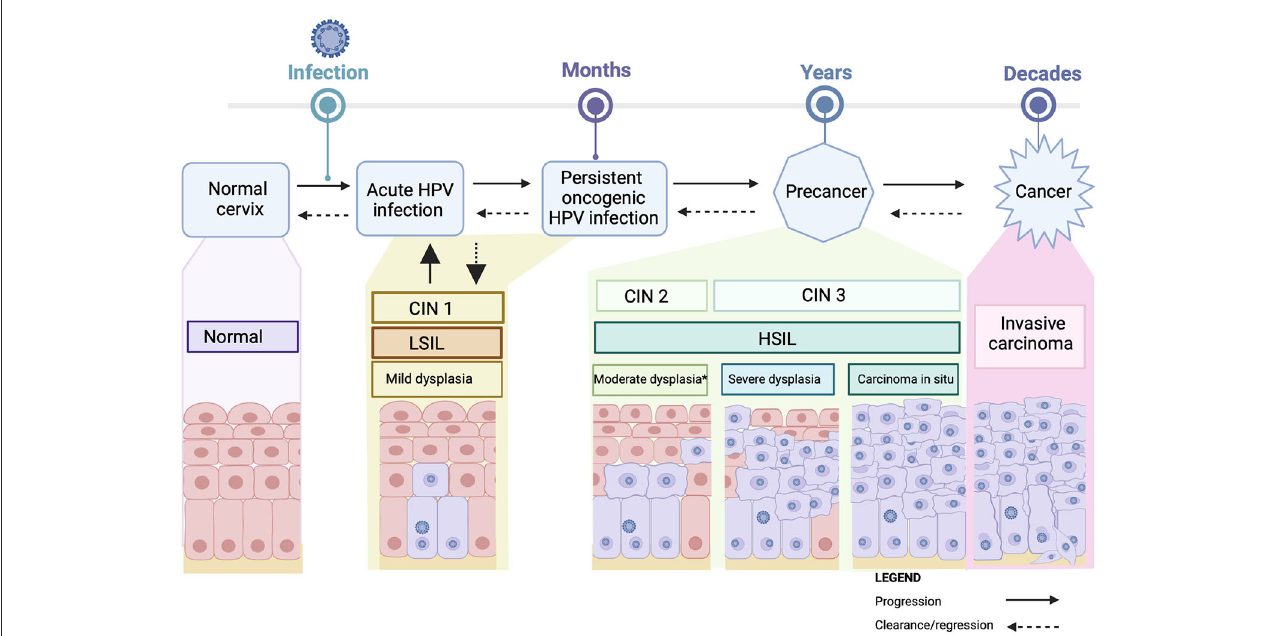
FIGURE1 Cervical carcinogenesis. Acute Infection with HPV may cause mild cervical abnormalities [CIN I (mild dysplasia/LSIL)], which usually clear spontaneously. Persistent infection with oncogenic HPV can result in cervical pre-cancerous lesions [CIN 2 (moderate dysplasia), CIN3 (severe dysplasia or carcinoma in situ /HSIL)] which can progress over time to invasive cancer. Progression is not inevitable, with regression possible at any stage. * sometimes acute infections/infections with lower risk HPV types can produce an appearance that is identified as moderate disease (CIN2). CIN2 is a heterogeneous entity likely comprising “severe CIN1 cases” and “mild CIN2” cases rather than a single disease state with a uniform prognosis. HPV, human papillomavirus; CIN, cervical intraepithelial neoplasia; LSIL, low-grade squamous intraepithelial lesions; HSIL, high-grade squamous intraepithelial lesions. Created with